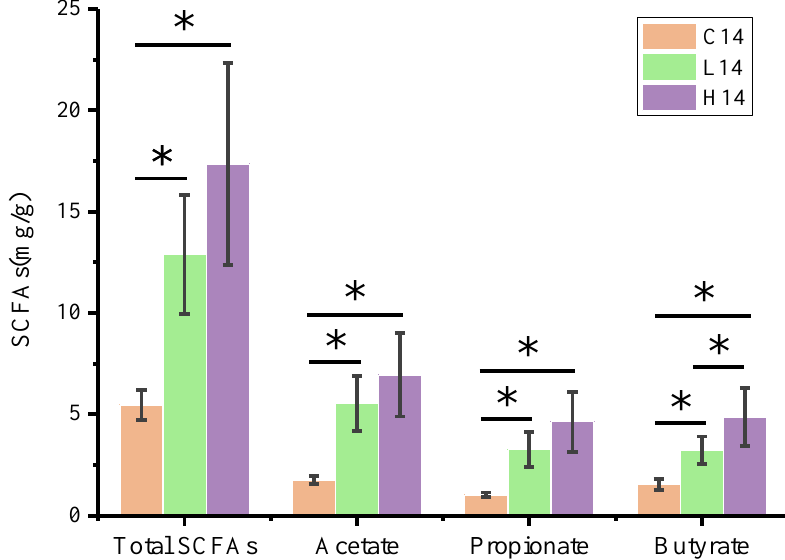
Figure 5. Effect of PS on the SCFA concentration in feces. * Indicates that there was significant difference between groups ( p < 0.05).